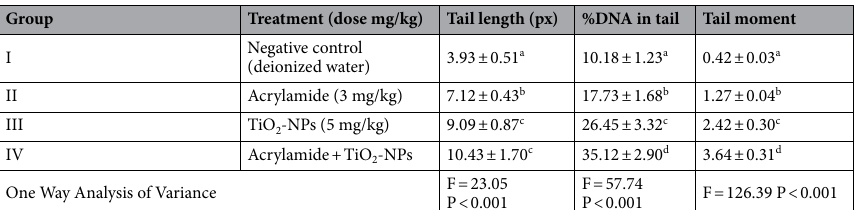
Table 2. Tail length (px), %DNA in tail and tail moment in the brain tissue of the negative control group and groups administered acrylamide or/and TiO 2 NPs. Results are expressed as mean ± SD. Results were analyzed using one-way analysis of variance followed by Duncan’s test to test the similarity between the control and three treated groups. Means with different letters indicates statistical significant difference between the compared groups in the same column.